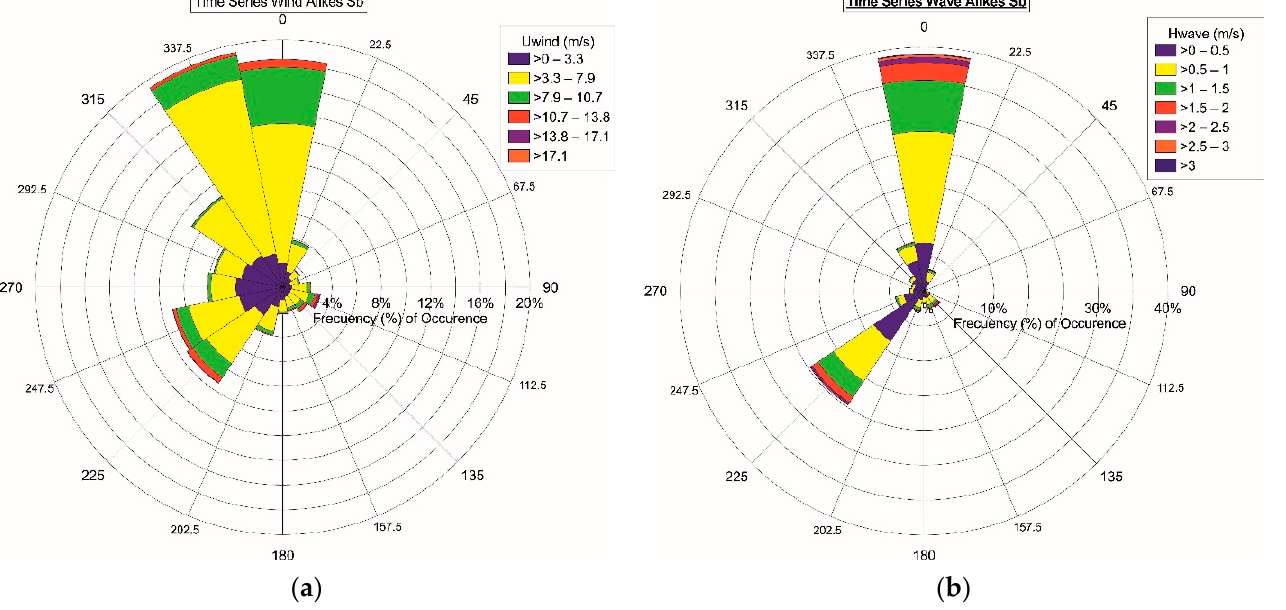
Figure 2. ( a ) Wind and ( b ) wave rose diagrams for the study area.